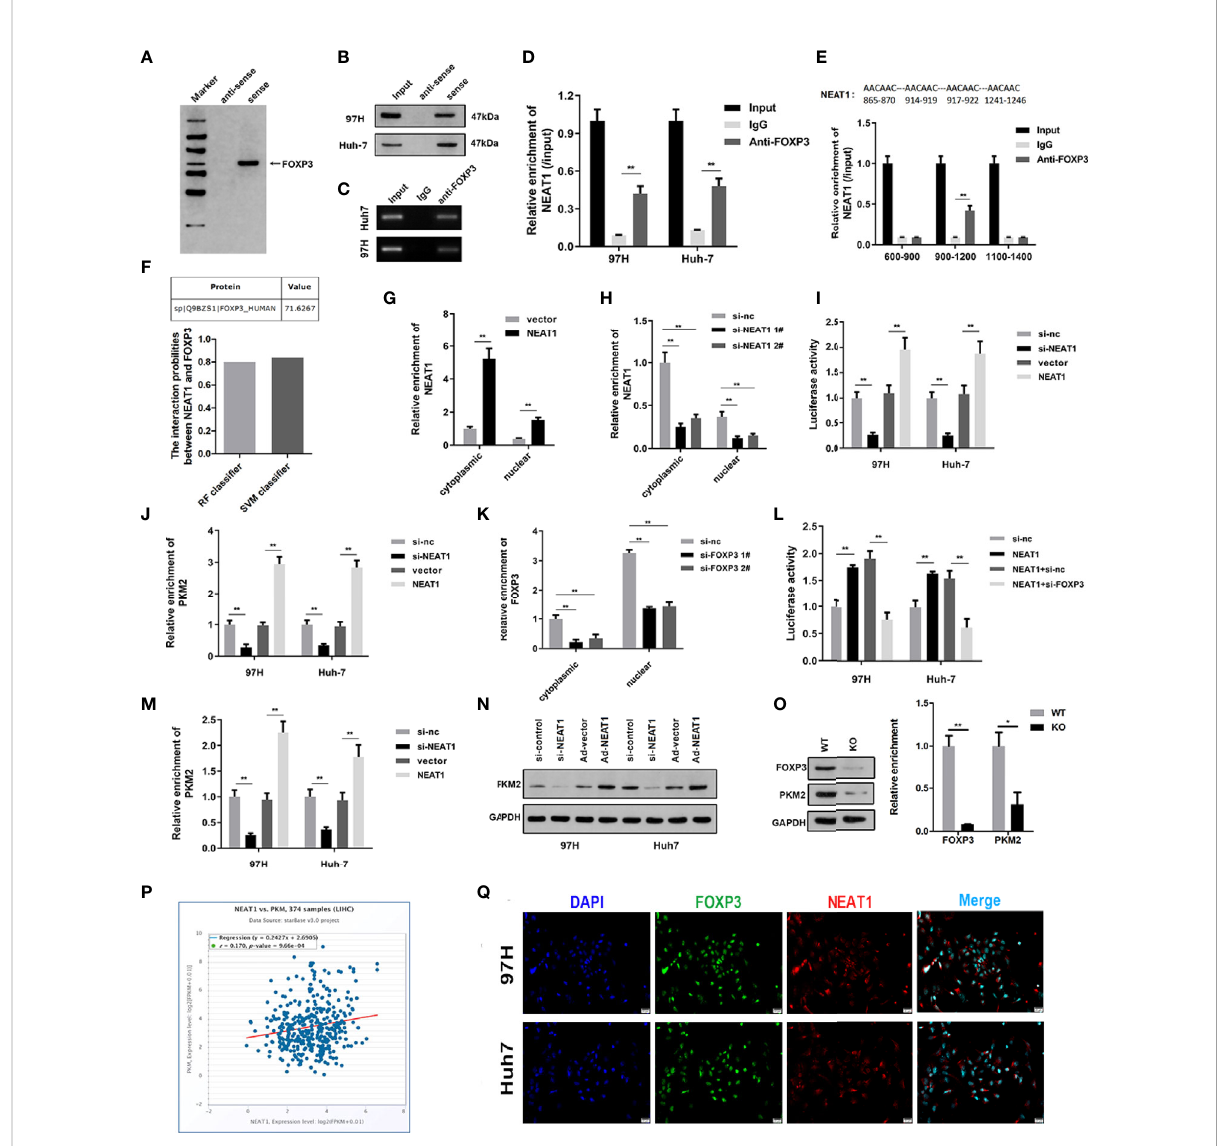
FIGURE 2 NEAT1 binds FOXP3 to promote PKM2 transcription. (A) RNA pulldown, silver staining, and mass spectrometry analysis were carried out to investigate the interaction between NEAT1 and FOXP3. (B) RNA pulldown was performed to verify the binding between NEAT1 and FOXP3. (C, D) RIP experiments con fi rmed the binding between NEAT1 and FOXP3. (E) Bioinformatics predicted the binding sites of NEAT1 and FOXP3, and RIP again found that NEAT1 was the binding site in the 900 – 1,200 fragment of FOXP3. (F) Bioinformatics catRAPID predicted the combination score of NEAT1 and FOXP3, proving that the possibility of the combination was high. (G, H) After overexpression or knockdown, qPCR was used to assess the expression of NEAT1 in the cytoplasm and nucleus. (I) A luciferase reporter experiment was performed to investigate whether NEAT1 overexpression or knockdown could change the transcription activity of PKM2. (J) A ChiP assay was performed to detect the interaction between FOXP3 and PKM2 under NEAT1 knockdown or overexpression. (K) qPCR was used to assess the expression of FOXP3 in the plasma and nucleus. (L) A luciferase reporter experiment was performed to investigate the transcription activity of PKM2 after the transfection of pcDNA3.1/NEAT1, si-FOXP3, or their combination. (M, N) qPCR and Western blot were used to detect the effect of NEAT1 overexpression or knockdown on PKM2 expression. (O) After the knockout of FOXP3 by Crispr/cas9, PKM2 expression was also weakened, con fi rming the regulatory relationship between FOXP3 and PKM2. (P) Bioinformatics analysis con fi rmed the positive correlation between NEAT1 and PKM2 expression. (Q) An immuno fl uorescence confocal co-localization experiment indicated the co-localization of NEAT1 and FOXP3. * indicates P < 0.05; ** indicates P <